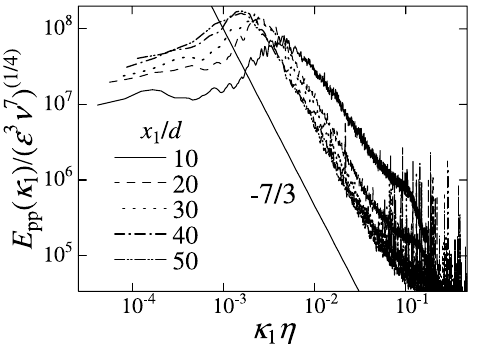
Fig. 18 Power spectra of fluctuating static pressure at x 2 / b (cid:3) 1 .